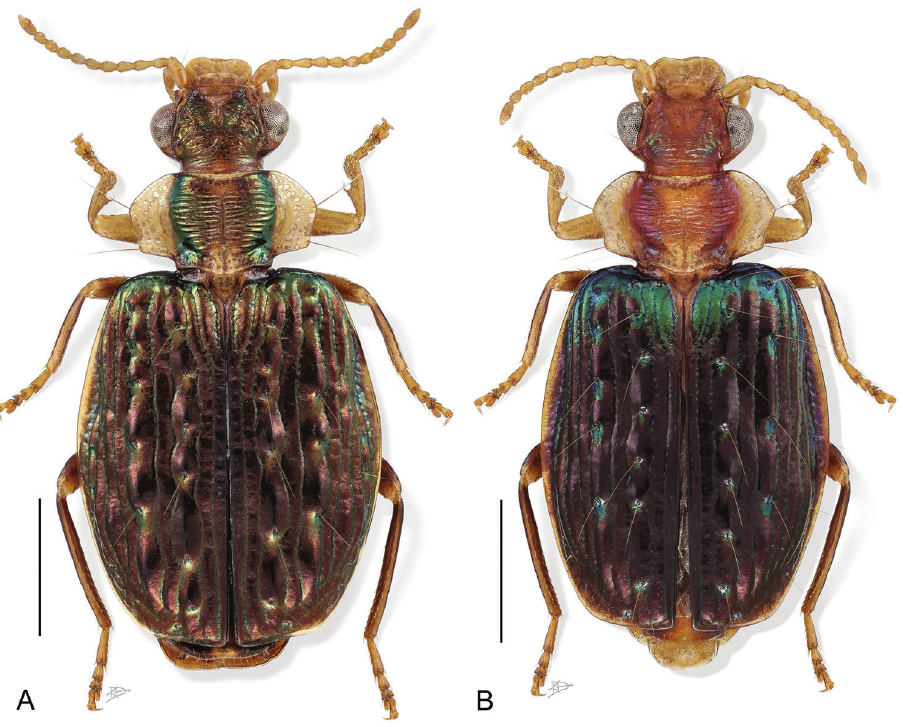
Figure 2. Digital Photo-illustration. Habitus, dorsal aspect. A Hyboptera vestiverdis Henry & Erwin, sp. n., female, ADP007334 B Hyboptera scheelea Erwin & Henry, sp. n., female,